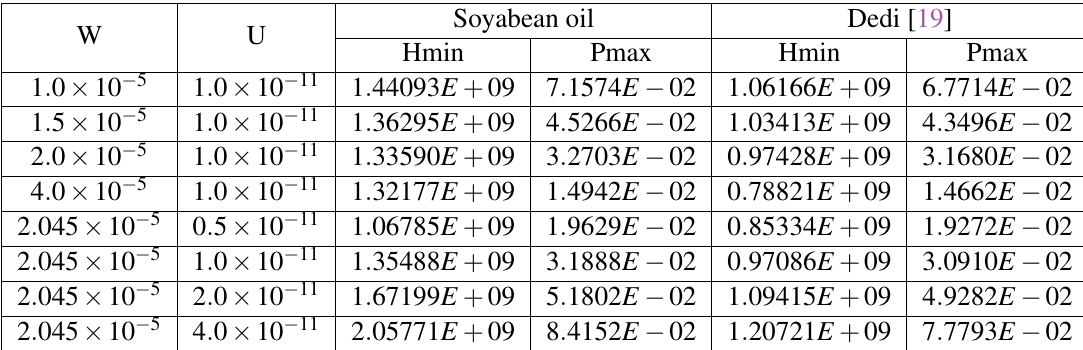
Table 4 Effect of dimensional load and speed on dimensional pressure and